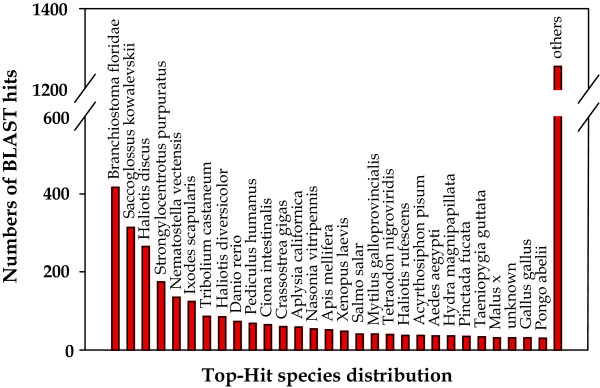
Distribution of the BLAST matches. Each bar of the histogram indicates the number of top-BLAST matches (the matches with the lowest E-value for each contig) against the Genbank non-redundant (NR) protein database to various species.